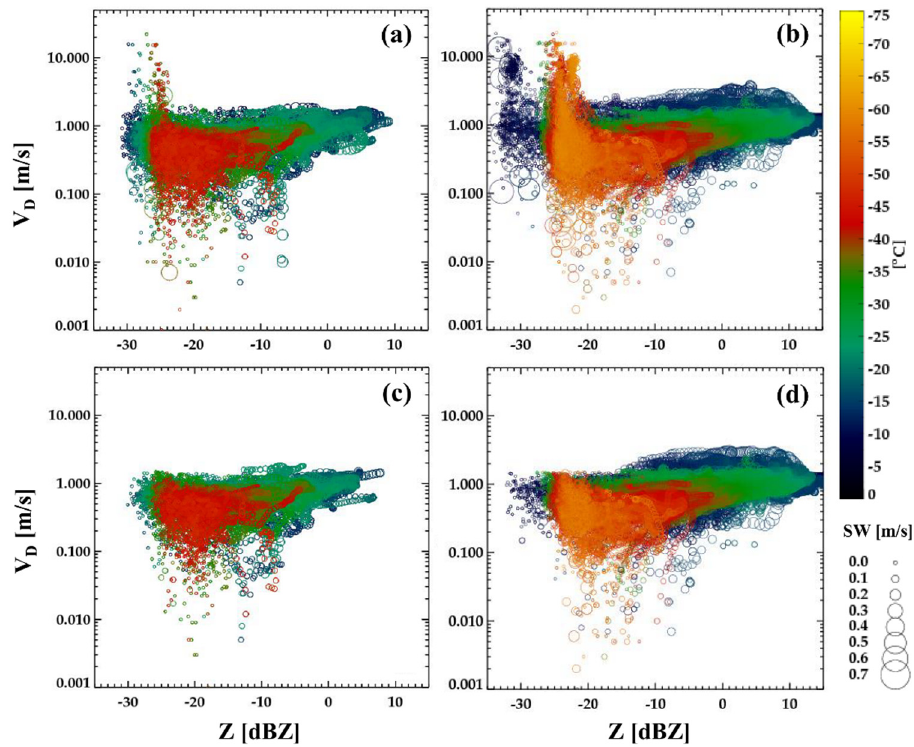
Figure 1. Scatterplots of Doppler velocity ( V D ) as a function of reflectivity ( Z ) of ( a ) before and ( c ) after applying quality control to a case of cirrus clouds on 25 September 2014 and ( b ) before and ( d ) after applying quality control for a case of anvil clouds on 22 May 2015. Circles indicate SW. Color